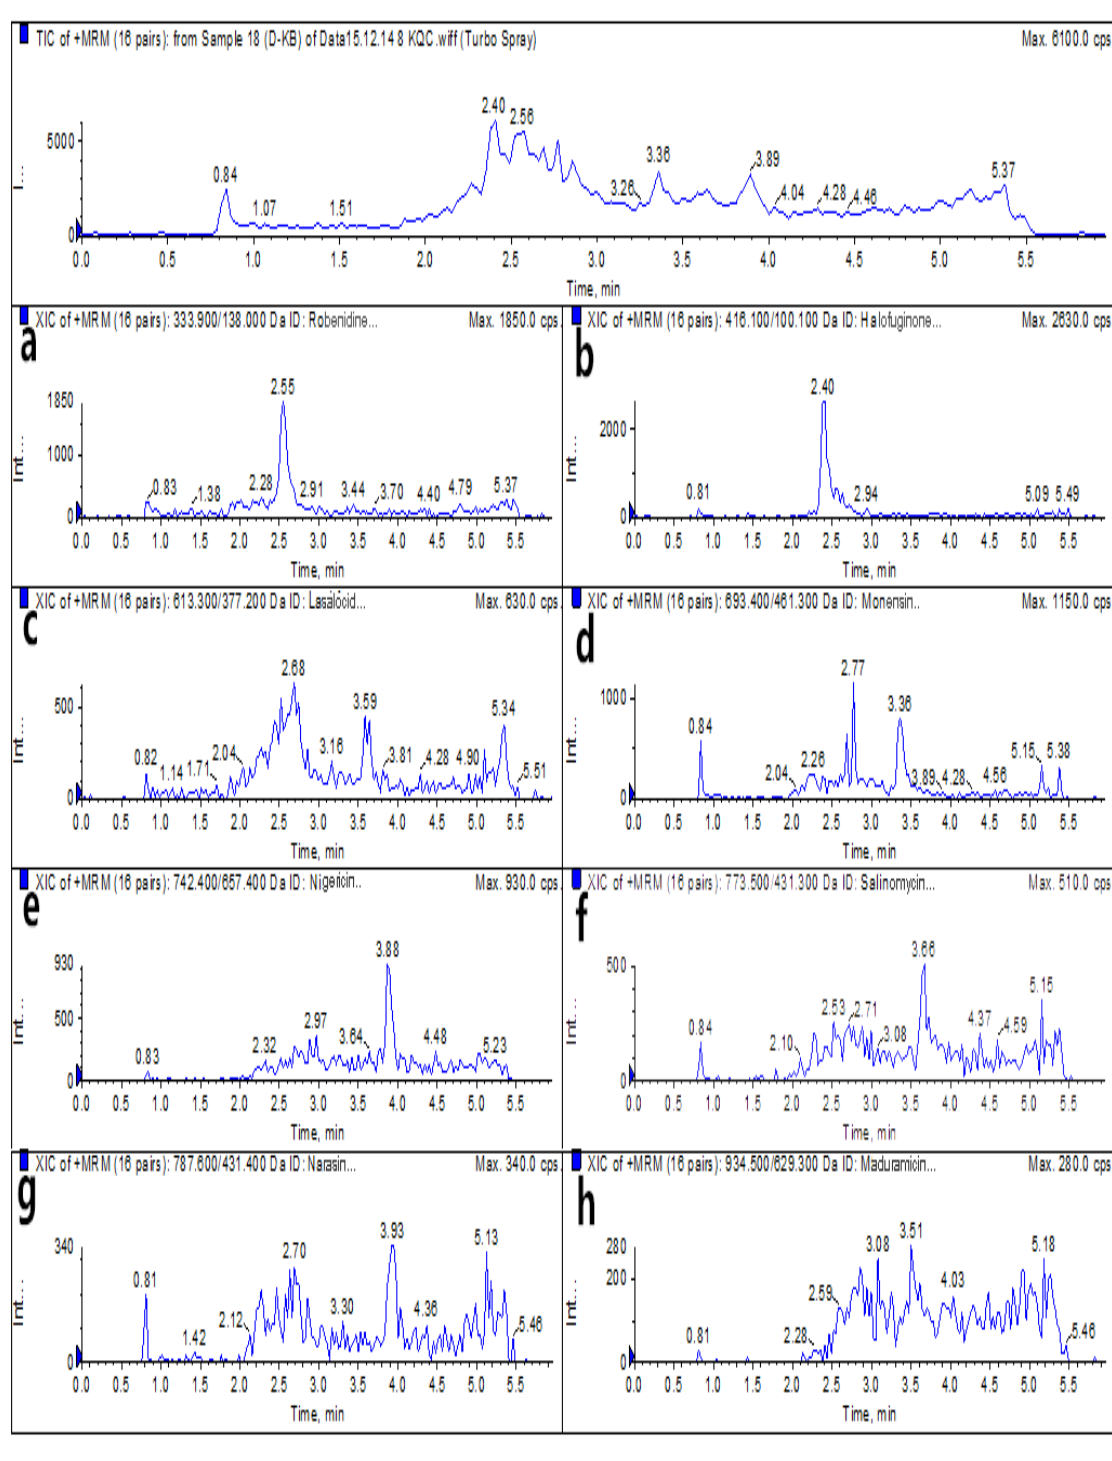
Figure 3. UPLC–MS / MS TICs and XICs ( a – h : ROB, HAF, LAS, MON, NIG, SAL, NAR, and MAD) of Figure 3. UPLC–MS/MS TICs and XICs ( a – h : ROB, HAF, LAS, MON, NIG, SAL, NAR, and MAD) of eight coccidiostats in a blank egg eight coccidiostats in a blank egg sample.